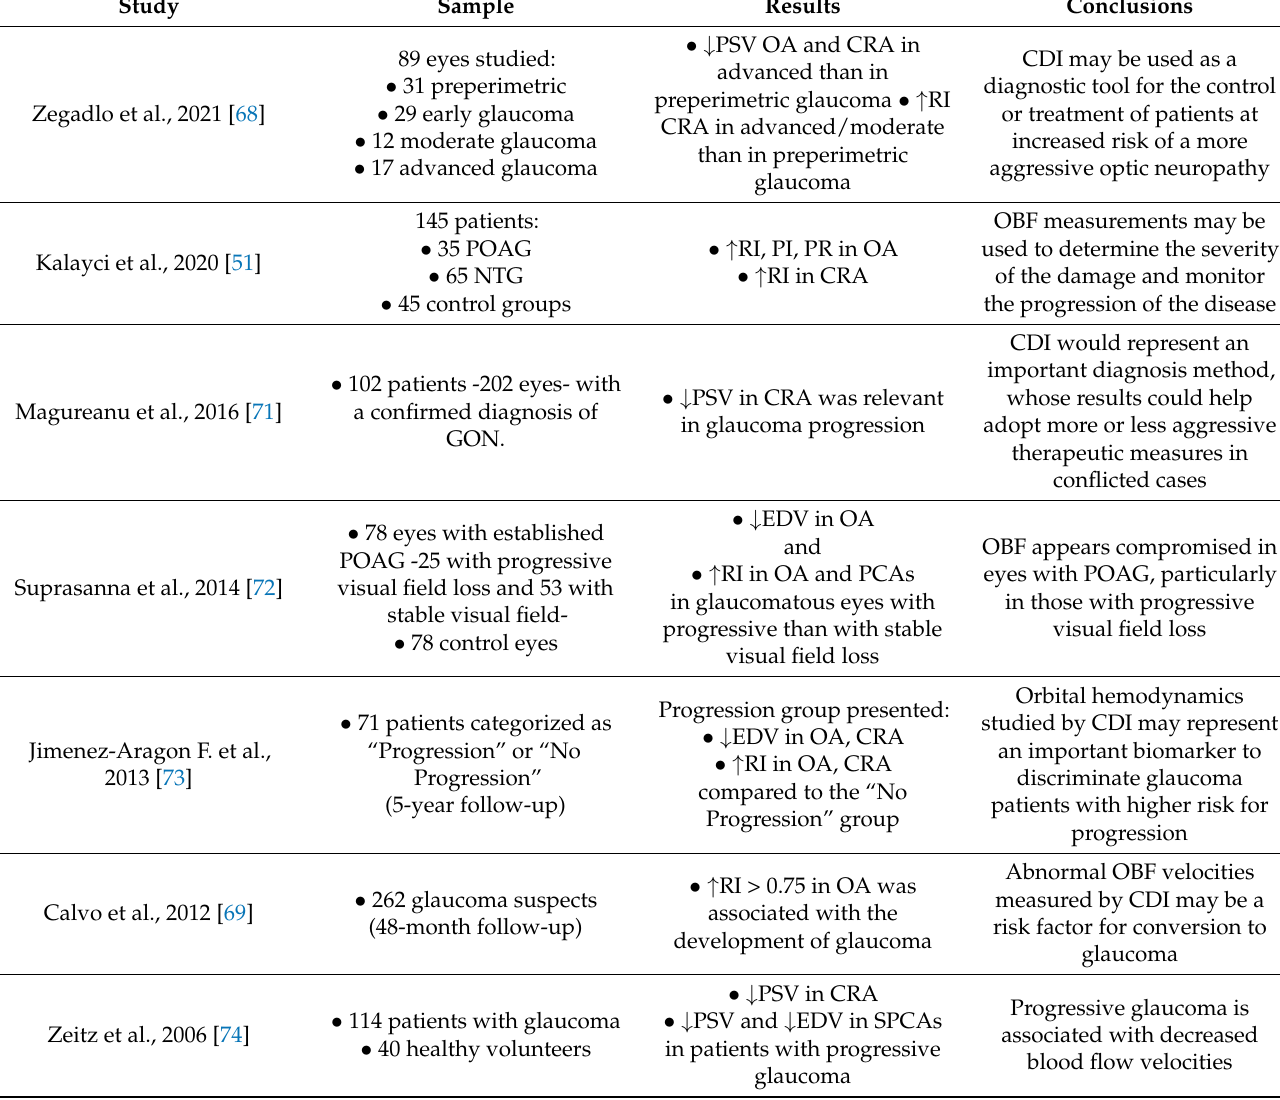
Table 5. CDI as a tool to monitor